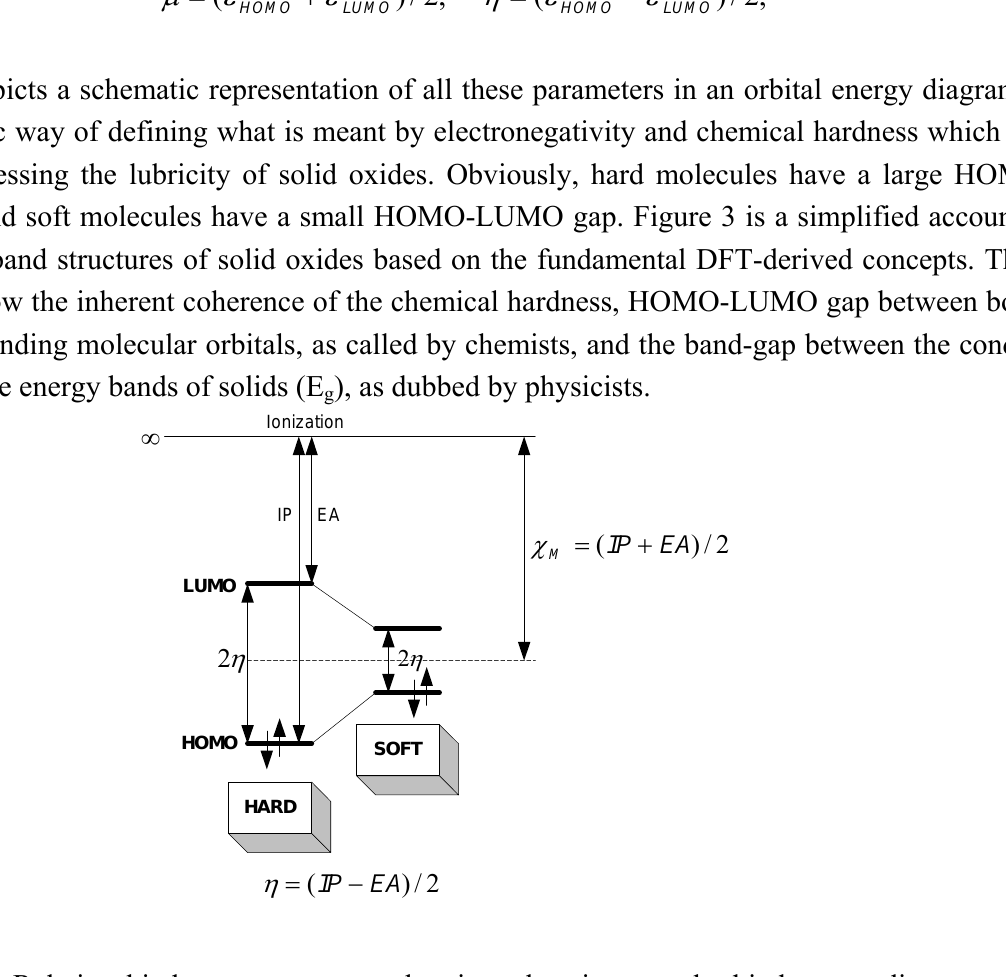
Figure 2. Relationship between quantum chemistry descriptors and orbital energy diagram.